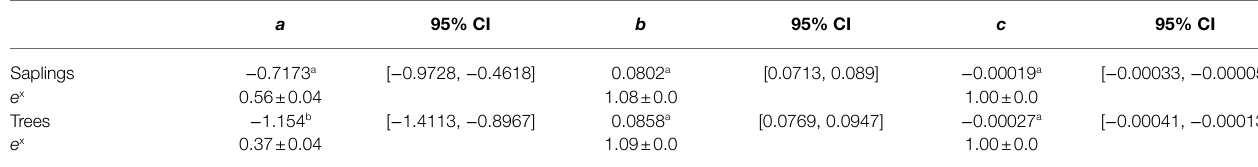
TABLE 2 | Model parameters fit to the measured high-resolution leaf respiration temperature response curves collected from Picea glauca measured at the FTE in Alaska. a 95% CI b 95% CI c 95% CI Saplings − 0.7173 a